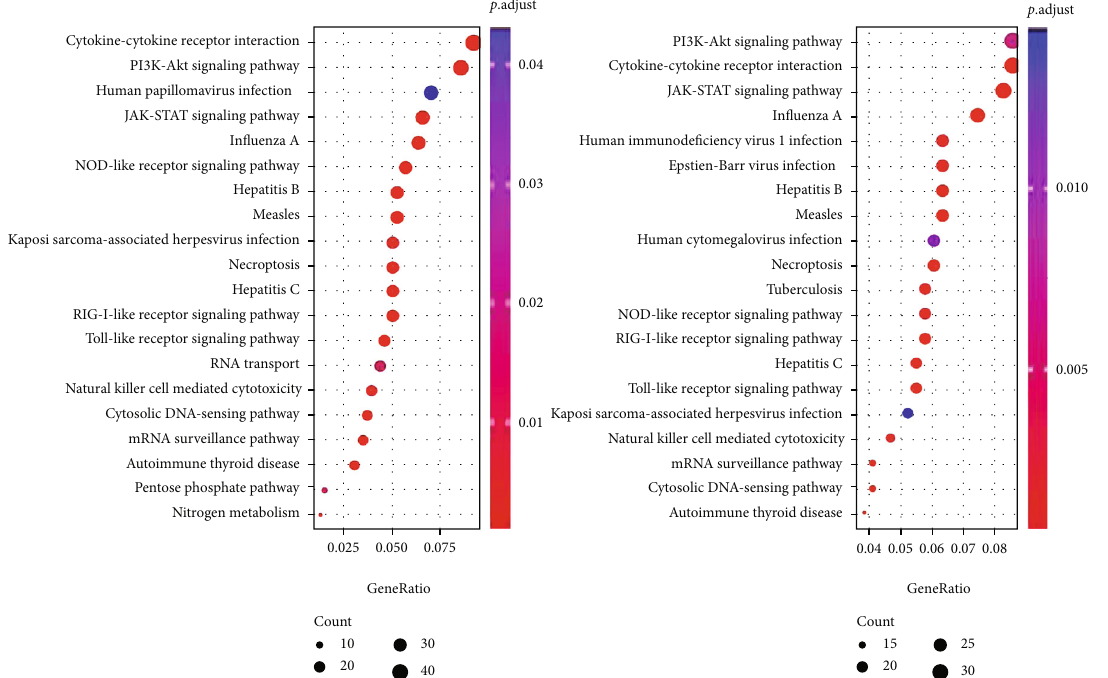
Figure 2: The pathway enrichment of screened genes with CNV in GBM and GSM.